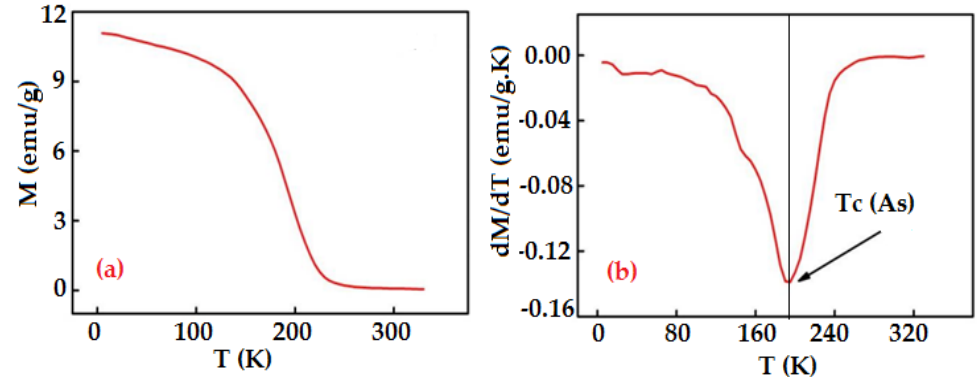
Figure 3. Temperature dependence of the magnetization measured at 500 Oe ( a ), and the derivative dM/dT curve showing the magnetic transition temperature ( Tc (As )) ( b ).